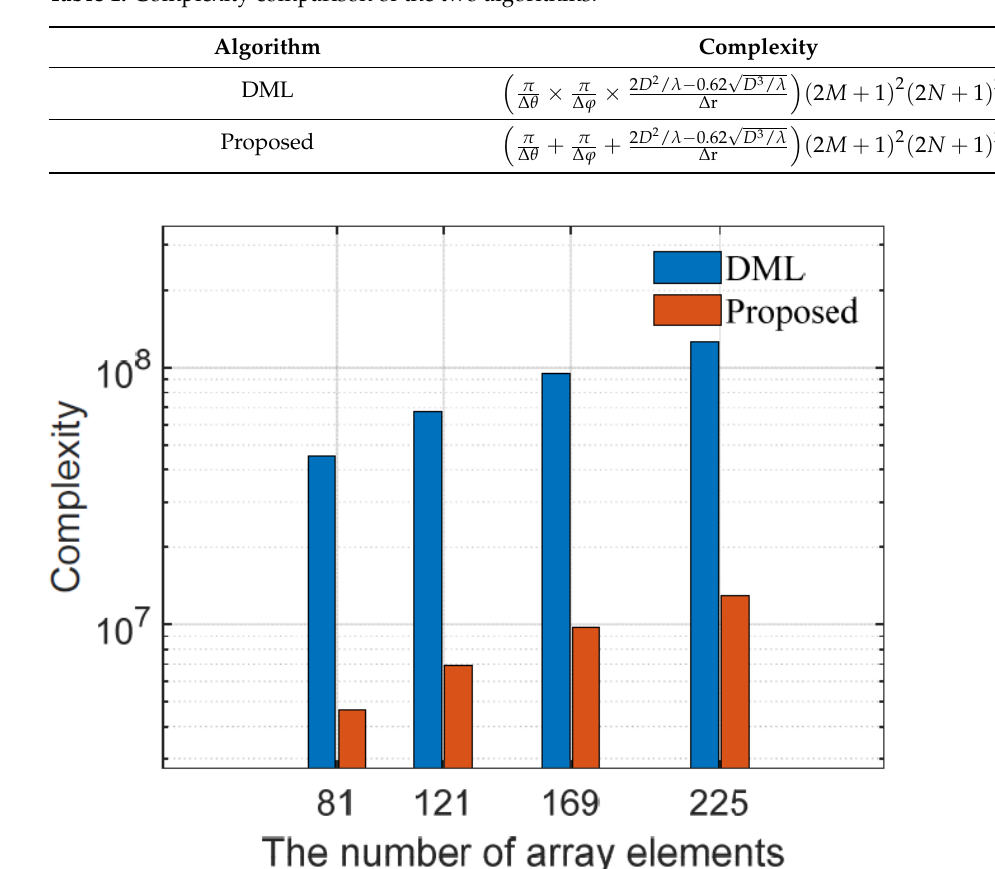
Table 1. Complexity comparison of the two algorithms.